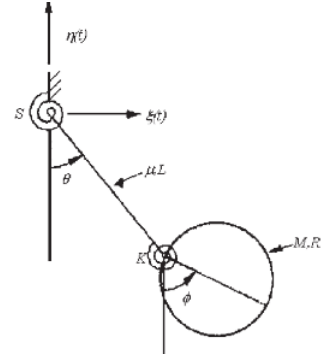
Figure 7. Mathematical model of fruit shaking ( Cooke & Rand